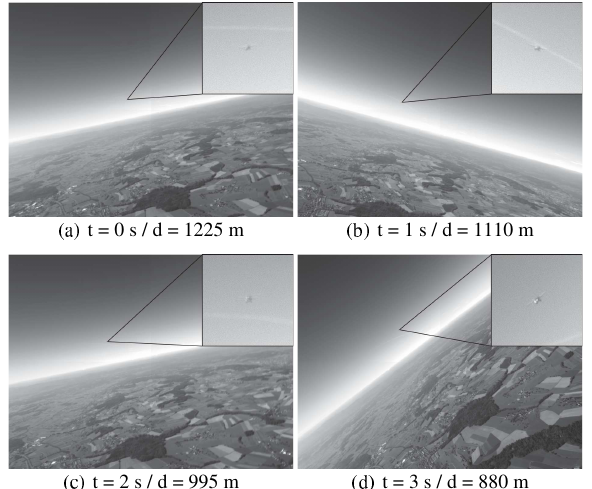
Figure 1: Example images of an approaching traffic aircraft recorded from an aerial platform during a dynamic flight maneu- ver. The upper right corner shows a magnified cutout of the in- coming traffic. Notice that sky as background eases detection.